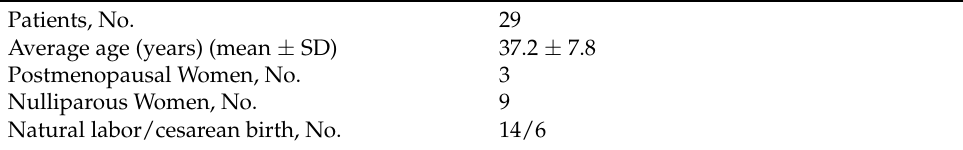
Table 1. Demographic and Clinical Information of the Subjects. Patients,